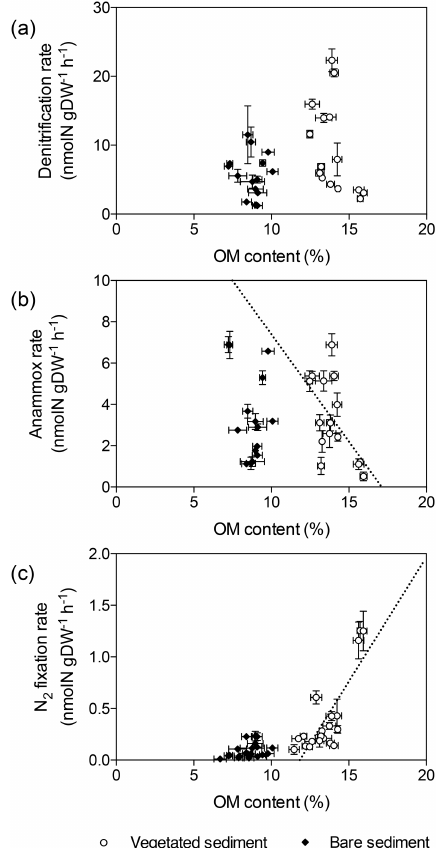
Figure 3. Relation of denitrification, anammox, and N 2 fixation rates with sediment OM content. (a) Denitrification rates in vege- tated sediments (white dots) and bare sediments (black diamonds). (b) Anammox rates in vegetated (white dots) and bare (black dia- monds) sediments, showing the linear decrease of anammox rates in vegetated sediments with increasing OM content (dotted line) (c) N 2 fixation rates in vegetated sediments (white dots) and bare sediments (black diamonds), showing the linear increase of N 2 fix- ation rates in vegetated sediments with increasing OM content (dot- ted line). Error bars indicate